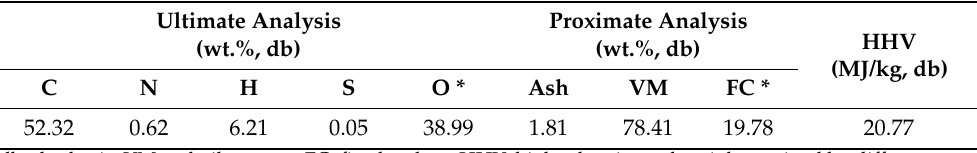
Table 2. Ultimate, proximate and higher heating value (HHV) analyses for pine kernel shells (PKS). Ultimate